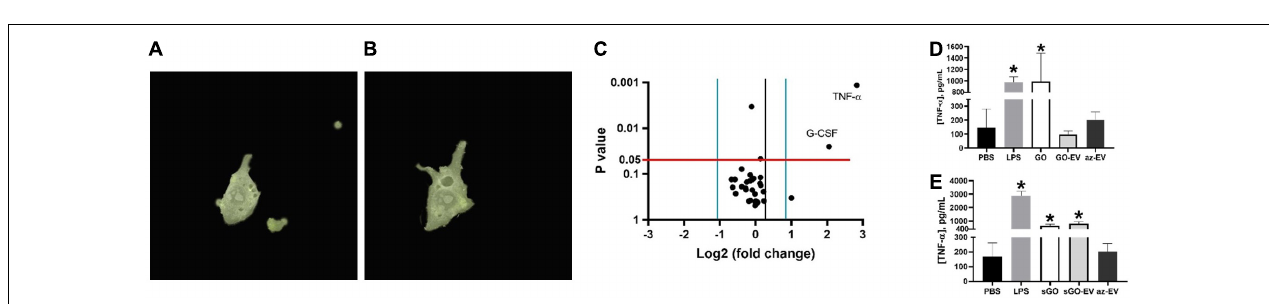
FIGURE 6 | Effects of GO-EV on macrophages. (A) Time-lapse imaging of RAW264.7 murine macrophages incubated with PKH67 labeled GO-EV was performed. Images were captured (A) before uptake, and every 5 min following the addition of GO-EV to the cells. Imaging was ceased once the biomaterial was (B) successfully internalized by the RAW264.7 cells. Extracellular background masks were applied to the image. (C) RAW264.7 cells were incubated with PBS or 4 µ g/ml GO-EV. After 3 h, conditioned media was collected, and assays were performed to determine protein concentrations for a panel of 31 chemokines or cytokines. Proteins with a log-two-fold or more change in concentration in response to GO-EV treatment were identified. A TNF- α ELISA was performed to quantify the TNF- α secretion by RAW264.7 cells treated with (D) GO- and (E) sGO-based biomaterials. RAW264.7 cells were treated with PBS, 10 ng LPS, 0.4 µ g GO, sGO, GO-EV, sGO-EV, or az-EV for 24 h. Data represents average ± SD, ∗ p <